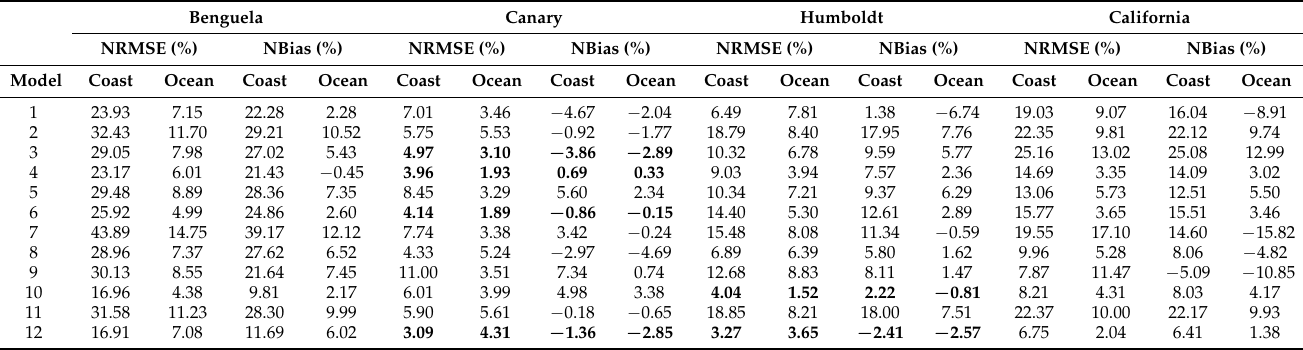
Table 2. NRMSE (%) and NBias (%) for each CMIP6 GCM at coastal and oceanic locations of each EBUS (see points in Figure 1). The number of each model refers to Table 1. Bold values indicate